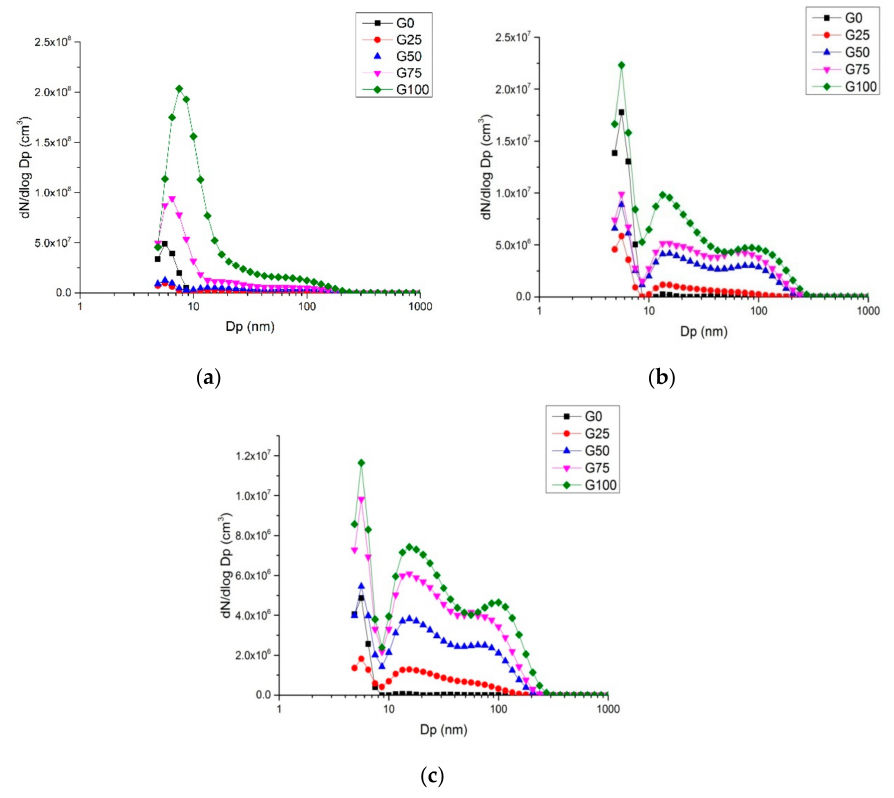
Figure 10. Particle size distribution with R e for di ff erent speed (The direct injection timing is 180 ◦ CA BTDC. The ignition timing is MBT. The intake manifold absolute pressure is 42 kPa): ( a ) 1500 r / min particle size distribution; ( b ) 1800 r / min particle size distribution; ( c ) 2100 r / min particle size distribution.